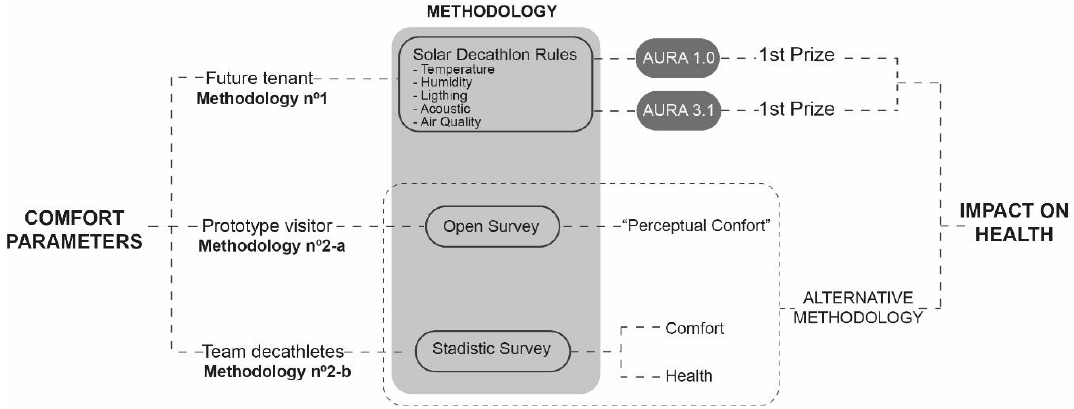
Figure 3. Methodology. Figure 3.